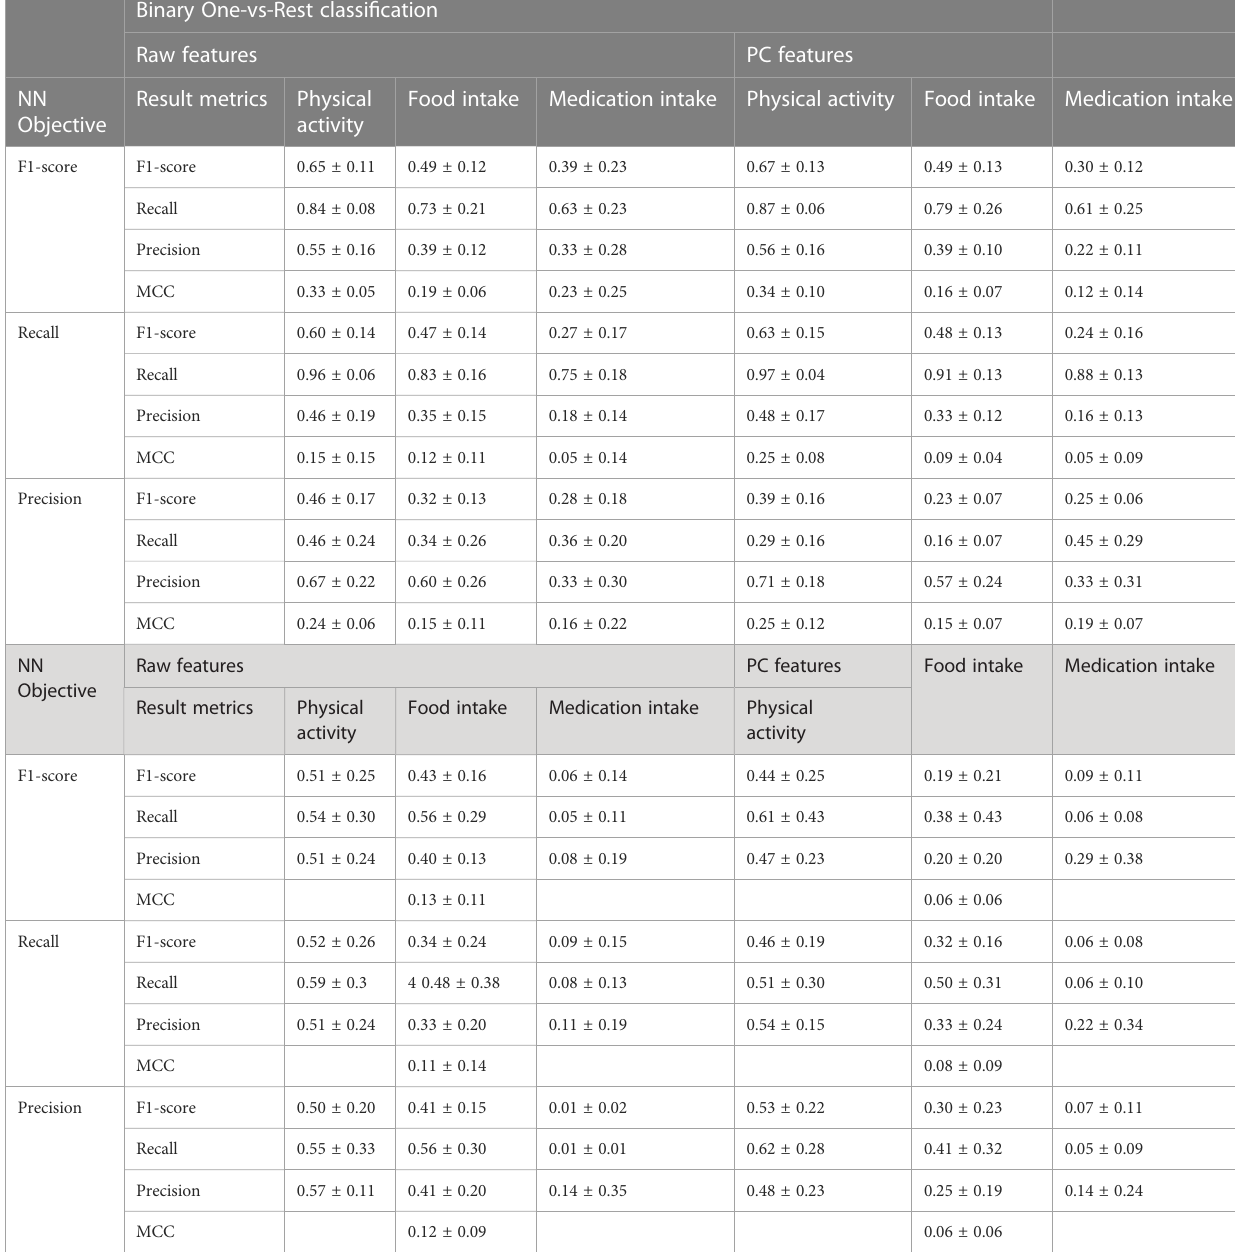
TABLE 3 Classi fi cation analysis results. Binary One-vs-Rest classi fi